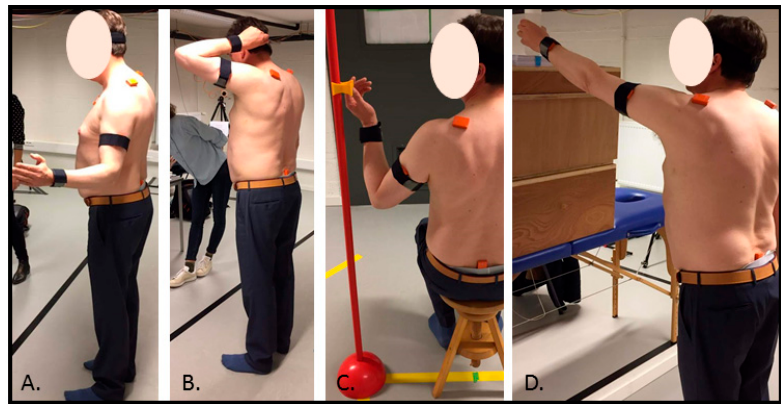
Figure 2. Motion analysis protocol. ( A ) Analytical GH external rotation; ( B ) combing hair; ( C ) grasping a seatbelt; ( D ) placing a cup on an overhead shelf. Remark: in ( C ) the seatbelt is removed to visualize the marker at eye level.